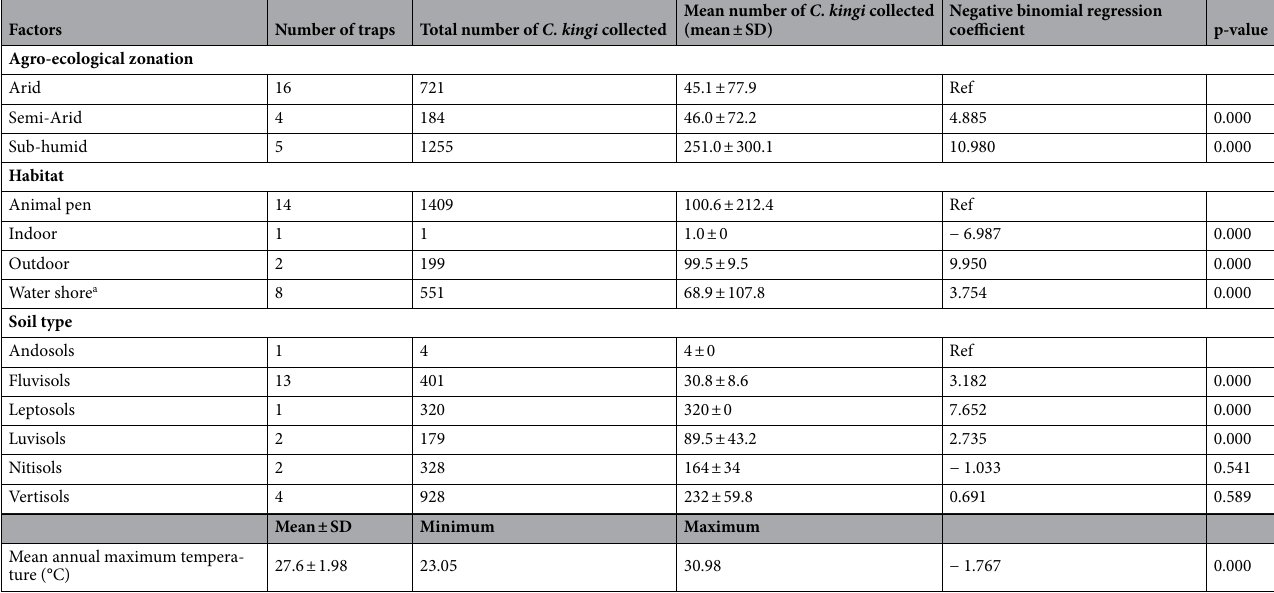
Table 5. Factors associated with C. kingi occurrence using multivariate negative binomial regression analysis. a Water shore includes river side, near pond, and lake shore.